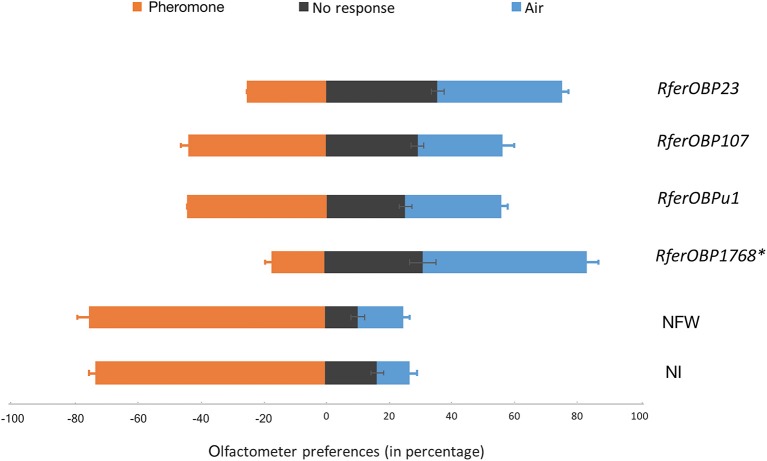
Olfactometer preferences exhibited by OBP-silenced (dsRNA-injected) RPWs against NI (not-injected) and NFW-injected insects to pheromone (4-methyl-5-nonanol (ferrugineol) and 4-methyl-5-nonanone (ferruginone) at the approximate ratio of 9:1), air or no response, as expressed as a percentage of the total (n = 12–16). Error bars represent the SEM. *The most highly significant difference in response (P < 0.001) compared to the control. The detailed statistical analysis is provided in Table S3.